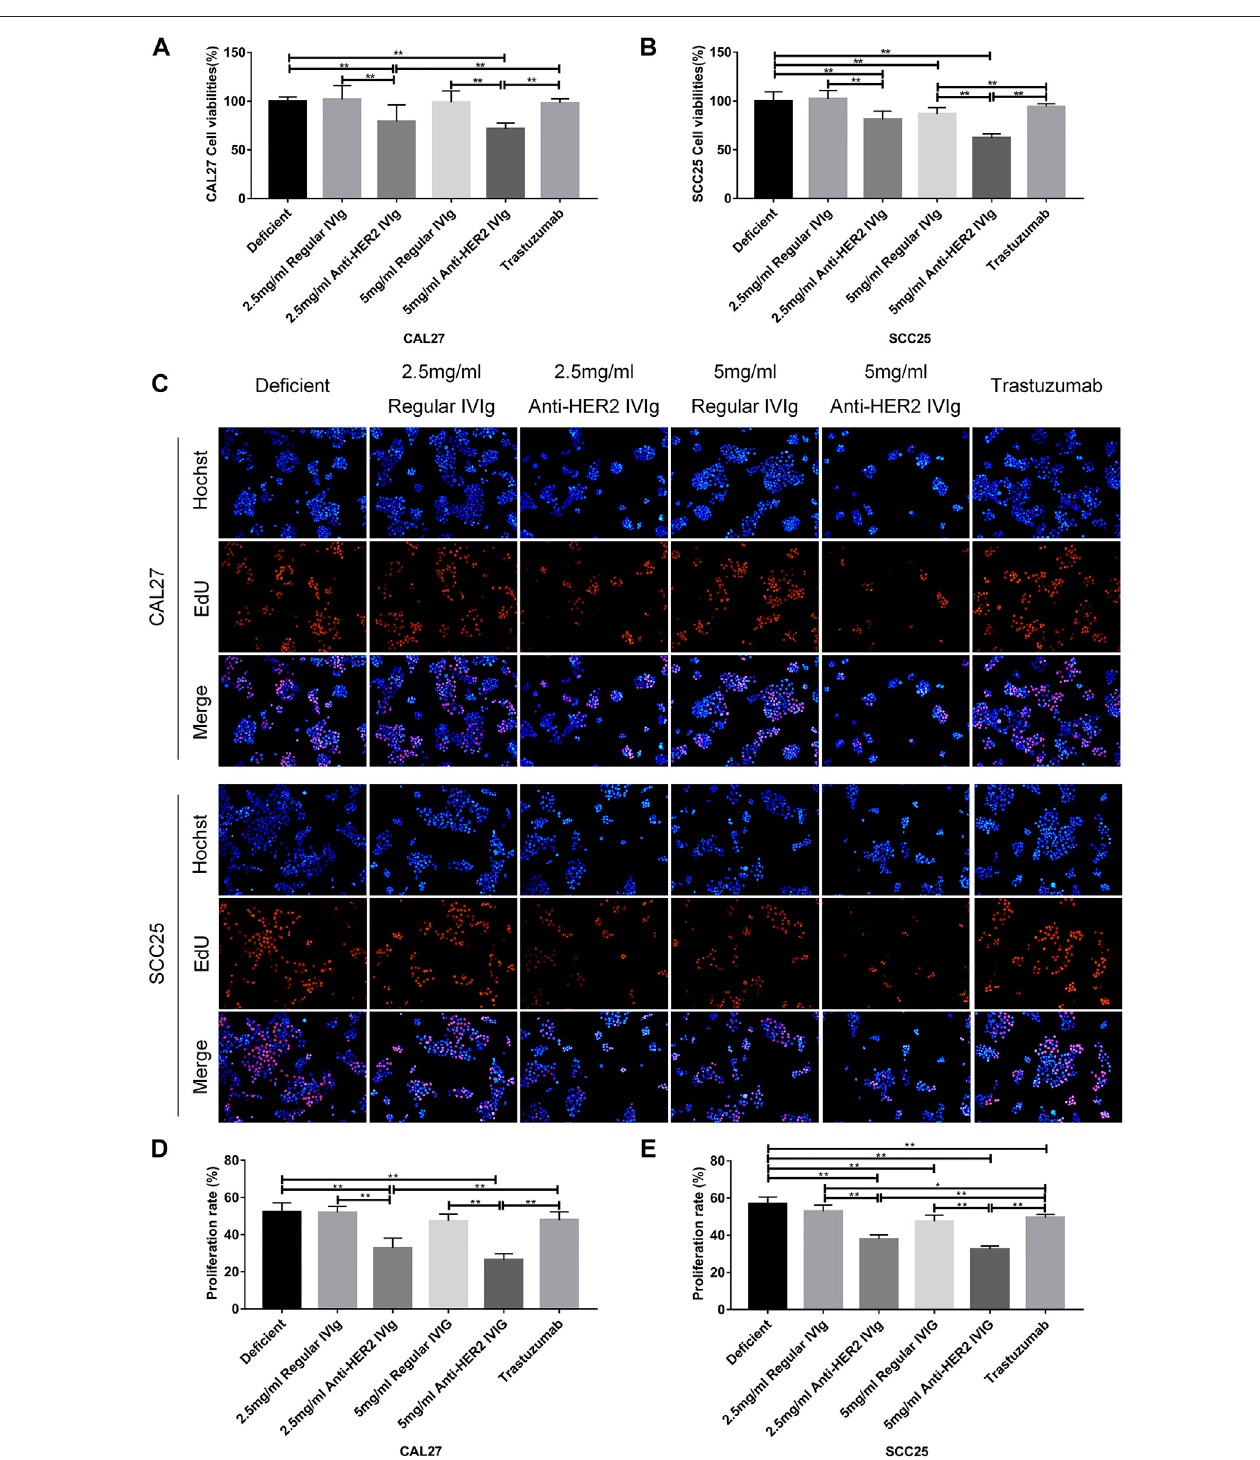
FIGURE4| Inhibitoryeffectofanti-HER2IVIgontheproliferationofOSCCcells. (A,B) ViabilityofCAL27cellsandSCC25cellstreatedwithanti-HER2IgG-de fi cient plasma only, anti-HER2 IgG-de fi cient plasma containing 200 μ g/ml trastuzumab, 2.5 mg/ml regular IVIg, 2.5 mg/ml anti-HER2 IVIg, 5 mg/ml regular IVIg, and 5 mg/ml anti-HER2 IVIg, respectively. (C – E) EdU staining of CAL27 and SCC25 cells treated with anti-HER2 IgG-de fi cient plasma only, 200 μ g/ml trastuzumab, 2.5 mg/ml regular IVIg, 2.5 mg/ml anti-HER2 IVIg, 5 mg/ml regular IVIg, and 5 mg/ml anti-HER2 IVIg, in medium containing 20% anti-HER2 IgG-de fi cient plasma. The data were expressed as mean ± SD in cell viability (%). De fi cient, anti-HER2 IgG-de fi cient plasma; IVIg, intravenous immunoglobulin; * p < 0.05; ** p < 0.01.